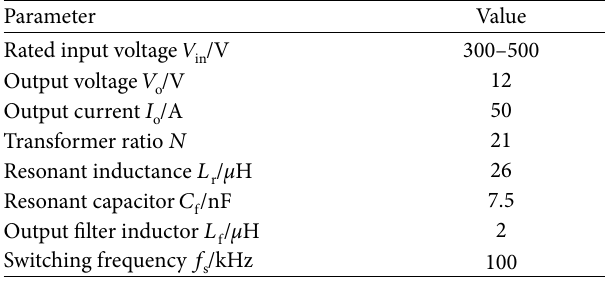
Table 1: Design parameters of DC/DC converters.